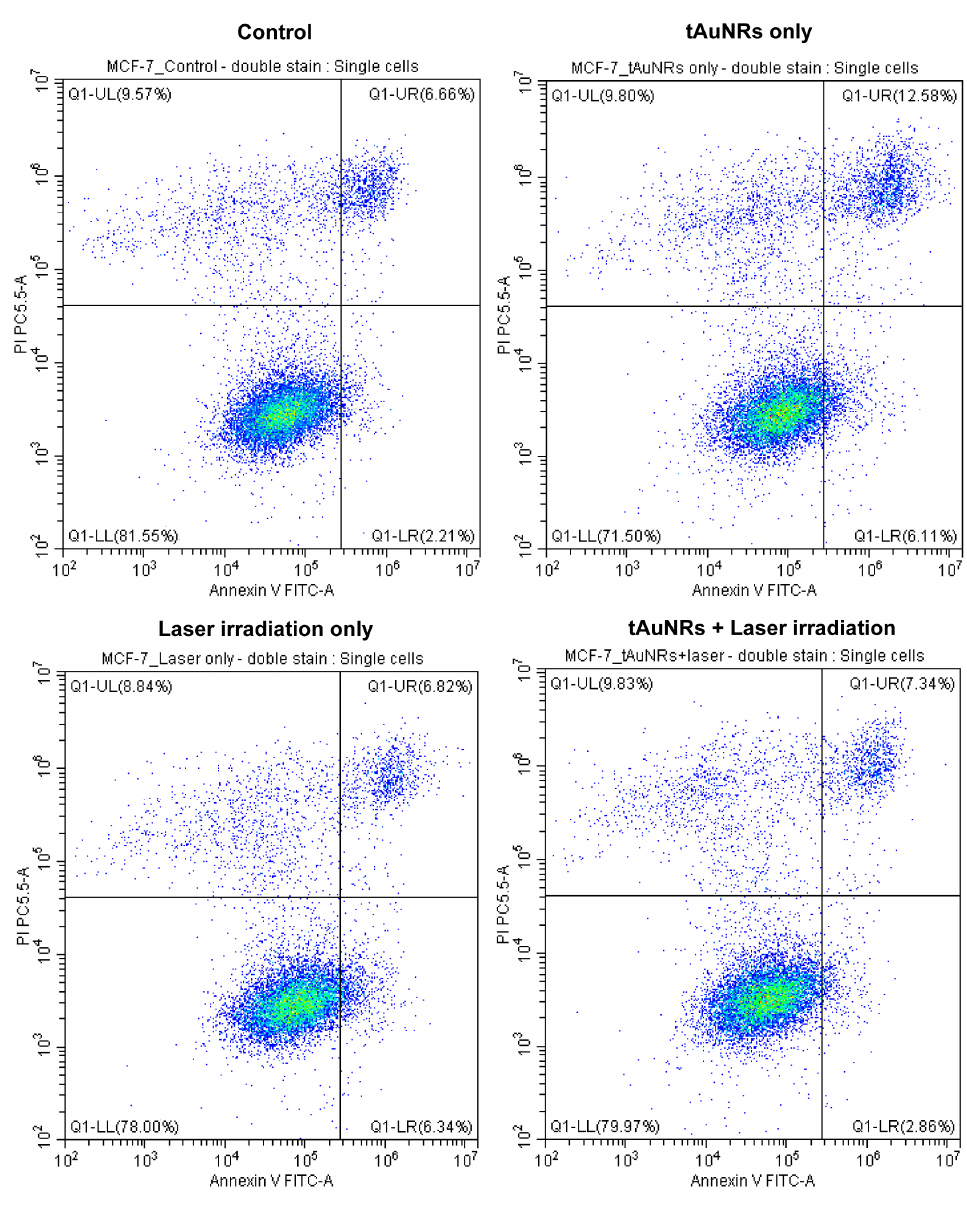
Figure 8. Apoptotic cell death in MCF-7 cells following tAuNR and laser treatment. Cells were incubated with tAuNRs alone, with laser irradiation alone or with their combination (tAuNRs + laser irradiation). Flow cytometry analysis of these cells stained with annexin V FITC and PI alongside untreated (control) cells is shown. Gating was determined based on the control cells and used for the treatment groups to determine the percentage of healthy cells (Q1-LL), cells in early apoptosis (annexin-V-positive, PI-negative, Q1-LR), cells in late apoptosis (annexin-V-positive, PI-positive, Q1-UR) and the percentage of cells undergoing necrosis (PI-positive, annexin-V-negative, Q1-UL). Total number of single cell events: control, 11,920; tAuNRs, 12,495; laser only, 11,775 and tAuNRs + laser, 12,079.